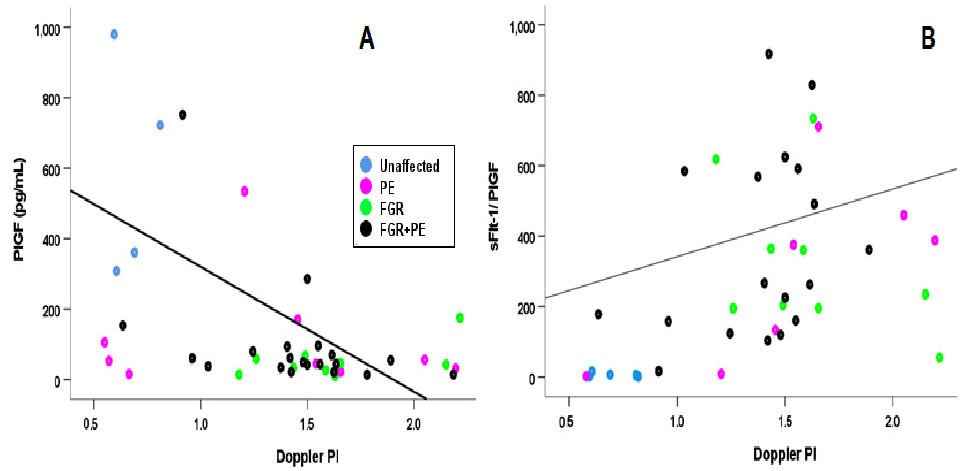
Figure 4. Correlation of the UtA Doppler PI with the Angiogenic Marker. A Spearman’s correlation for between UTA Doppler PI (Doppler PI in the Figure) and ( A ) PlGF and ( B ) sFlt-1/PlGF ratio. Blue—unaffected group, purple—PE, green—FGR, and black—PE + FGR.